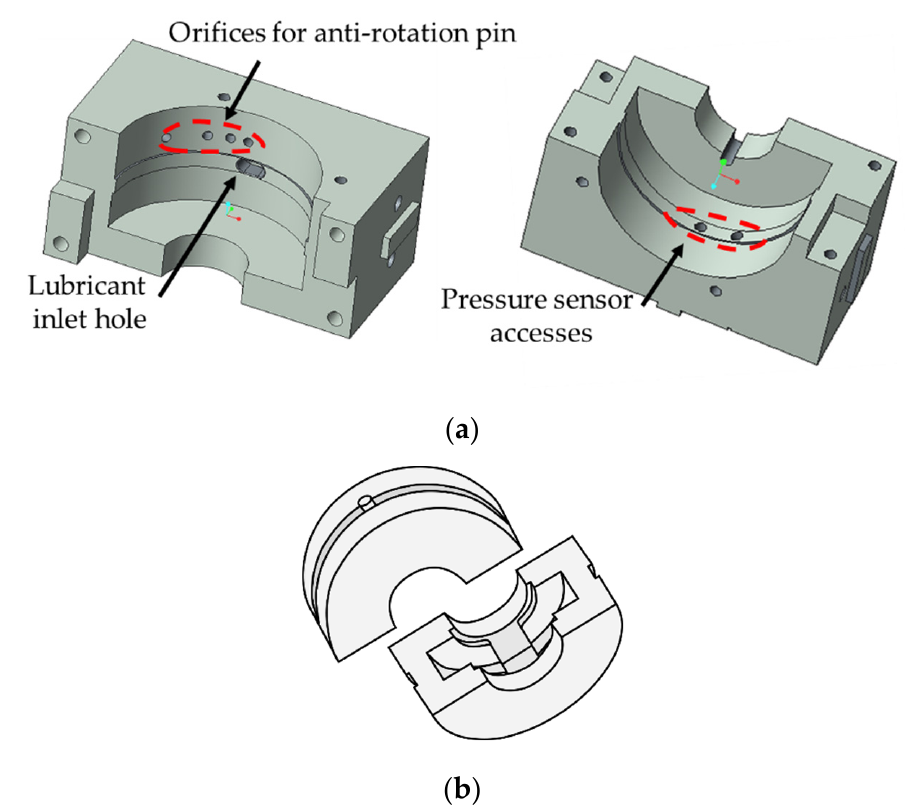
Figure 6. Arrangement for instrumentation access in the external housing structure. (A i ) Threaded holes for holder assembly of the inductive proximity probes; (B i ) threaded holes for the outlet oil collector clamping; (C) opening for PT100 sensor cables; (D) groove for pressure sensor cable; (E) threaded holes for accelerometer assembly; (F) lubricating oil inlet access.